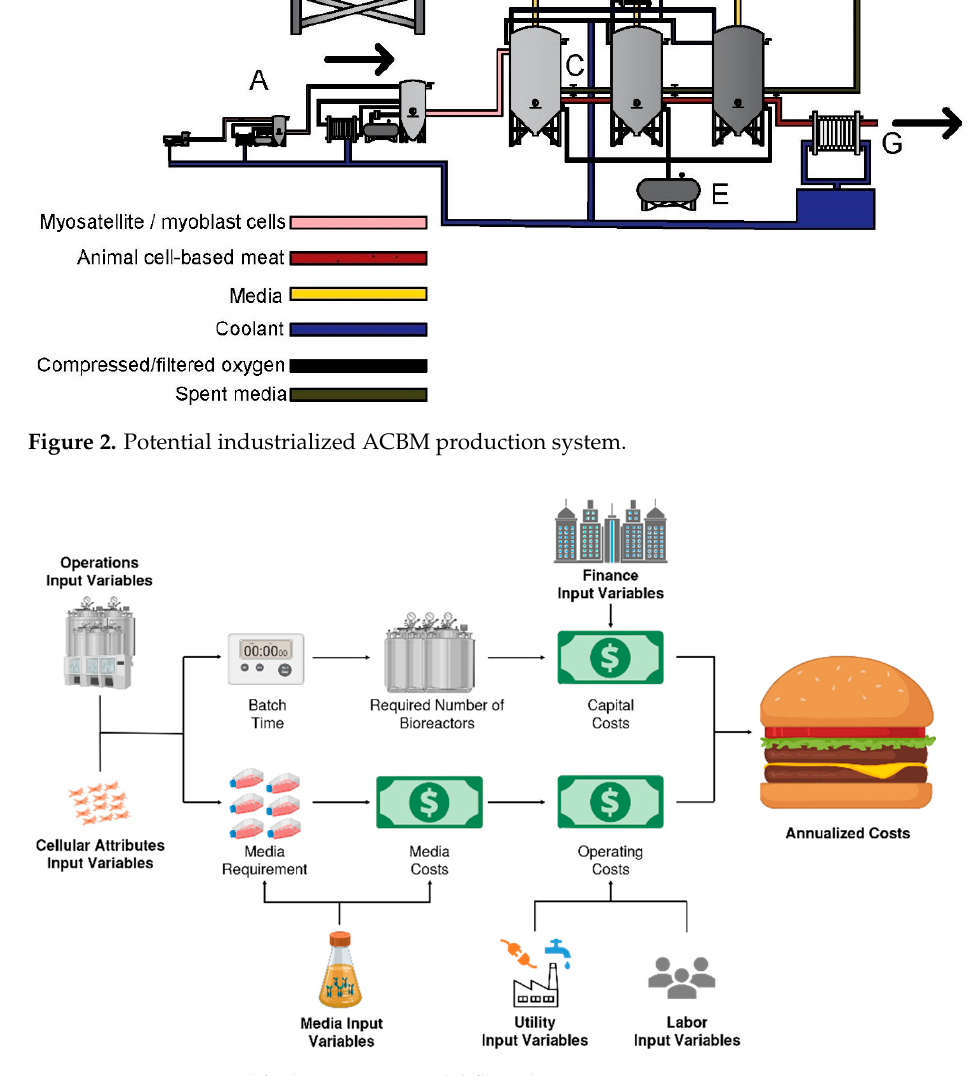
Figure 2. Potential industrialized ACBM production system.